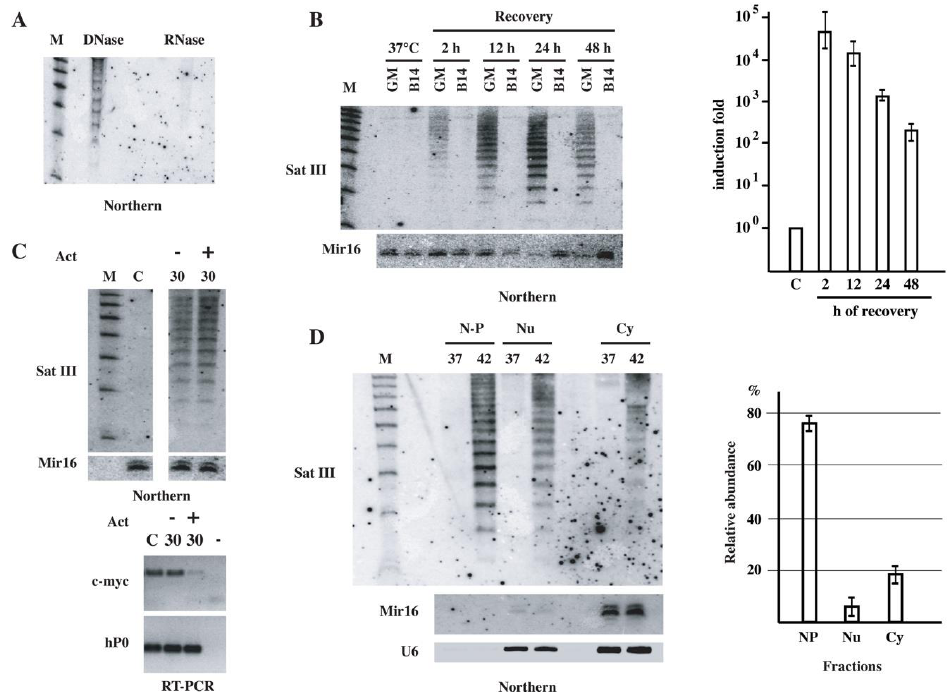
Figure 2. Characterization of short SatIII RNAs. ( A ) Short RNAs were prepared from heat-shocked HeLa cells allowed to recover at 37 ◦ C for 42 h. RNAs were digested with DNase I or with RNase A and then analyzed using Northern blotting with the LNA oligo specific for SatIII repeats. ( B ) Short RNAs were prepared from heat-shocked hamster B14-150 cells and from the hamster > human somatic cell hybrid GM-10611A containing human chromosome 9. RNAs were then analyzed using Northern blotting as in panel A. Hybridization to Mir16 was used as a loading control. The histogram shows the quantitation of long SatIII RNAs in unstressed (C) and in heat-shocked GM10611A cells allowed to recover at 37 ◦ C for the indicated time periods. Data are represented as mean fold increases ± standard deviation of three independent experiments. ( C ) Short RNAs were prepared from unstressed (C) and from heat-shocked (1 h at 42 ◦ C) HeLa cells allowed to recover for 30 h at 37 ◦ C in the presence or in the absence of Actinomycin D (5 µ g / mL) during the last 6 h of recovery. The same membrane was hybridized with the LNA probe against SatIII RNAs and with a probe against Mir16 (loading control). M: molecular size marker. Total RNAs prepared from the same cells were analyzed using RT-PCR to assess the level of c-myc RNAs to control the e ffi cacy of Act D treatment. RT-PCR analysis of hP0 RNA was used as a loading control. ( D ) Unstressed (37) and heat-shocked HeLa cells were collected after 40 h of recovery at 37 ◦ C and fractionated in nuclear pellet (N-P), nucleoplasm (Nu) and cytoplasm (Cy) fractions. Total and short RNAs were prepared from each fraction. Short RNAs were analyzed using Northern blotting with an LNA probe against SatIII repeats. As a control of loading and fractionation quality, the same filter was hybridized to a probe against Mir16 (mainly cytoplasmic) and U6 RNAs. Total RNAs from nuclear pellet, nucleoplasm and cytoplasm fractions were prepared from heat-shocked HeLa cells allowed to recover for 40 h at 37 ◦ C. RNAs were analyzed using quantitative RT-PCR. The histogram shows the relative abundance of SatIII RNAs in the three factions as determined in three independent experiments. Data are mean ± standard